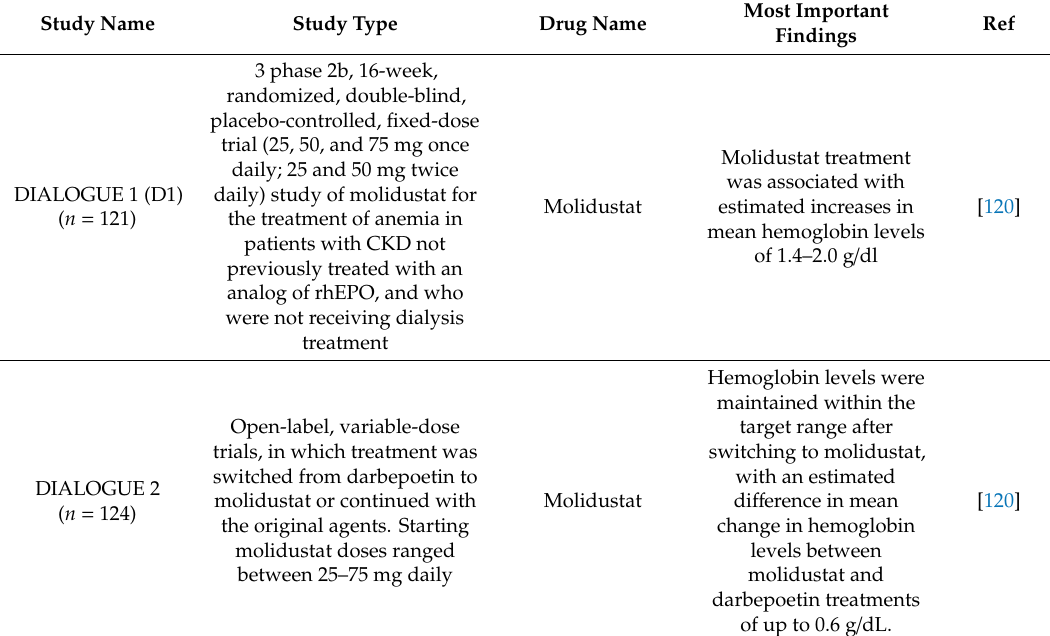
Table 1. The summary of trials concerning the use of new drugs in the treatment of anemia in CKD